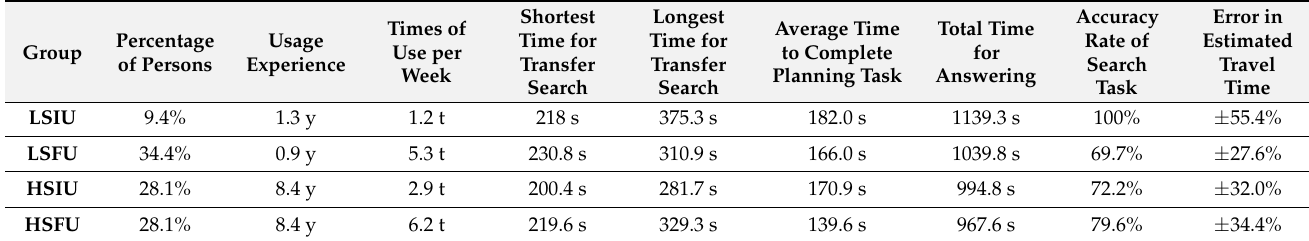
Table 7. Cluster analysis based on participants’ experience.